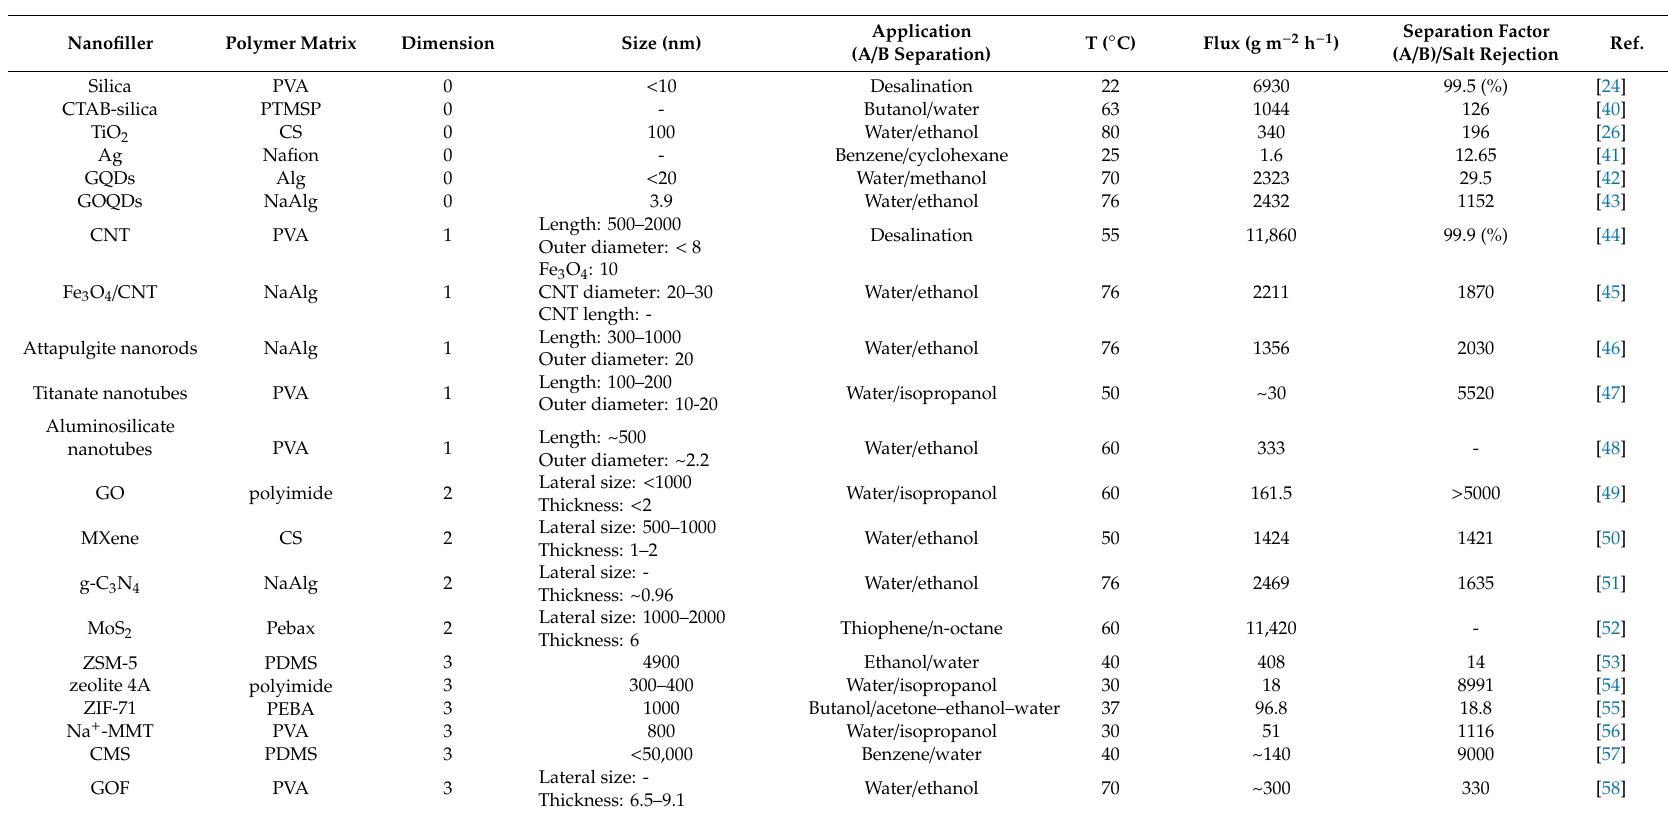
Table 1. Typical nanofillers of di ff erent dimensions in polymer matrices for